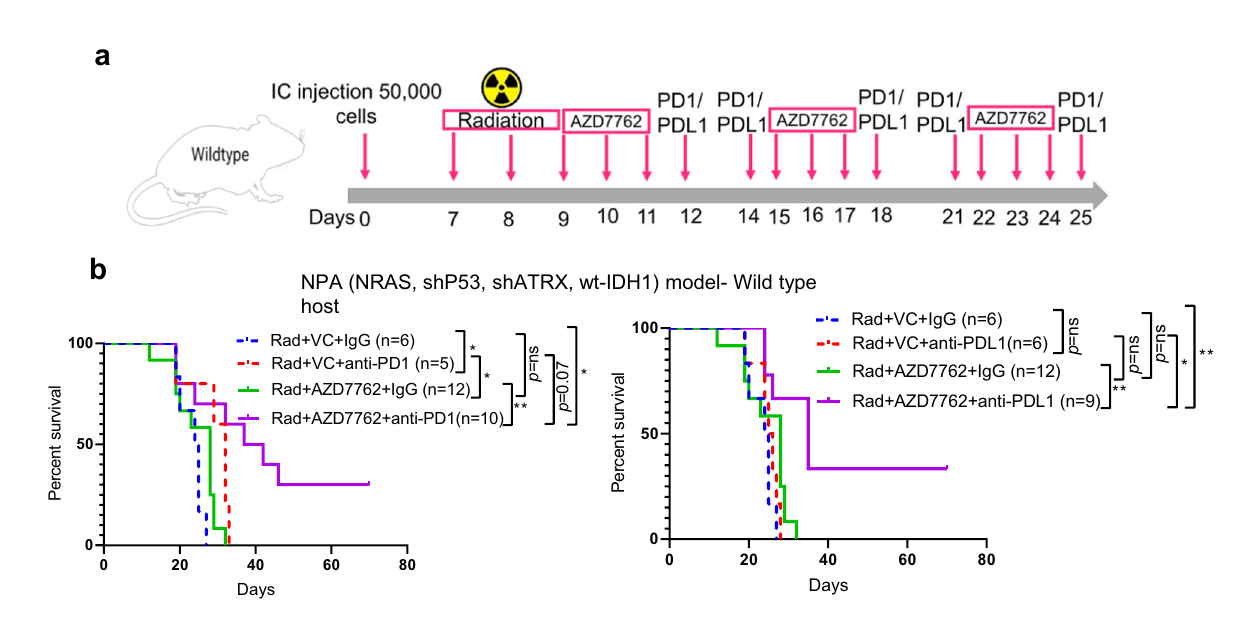
Fig. 8 | The combination of radiotherapy, AZD7762 and PD-1/PD-L1 blockade improves the survival of glioma-bearing mice in NPA glioma model. a The schematic representation of the dosing scheme followed for the survival experi- ment. b (Left) KM survival curves for NPA glioma-bearing C57BL/6 mice. Seven days after intracranial implantation, all the animals were irradiated with 3Gy whole-brain radiation for 3 consecutive days. 9 days after tumor implantation, the animals were randomized into 4 groups: vehicle control ( n =6), anti-PD-1 ( n =5), AZD7762(Chek1/2inhibitor)( n =12)andAZD7762+anti-PD-1( n =10)combination group.Survivalanalysiswasperformedusingthelog-ranktest.Themediansurvival duration in the treatment groups were as follows: Rad + VC+IgG, 24.5 days; Rad+ VC+anti-PD-1, 32 days; Rad + AZD7762+IgG, 28 days; Rad + AZD7762+anti-PD-1, 39.5days.Statistics:Rad+VC+IgGvsRad+VC+anti-PD-1, p =0.02;Rad+VC+IgG vsRad+AZD7762+IgG, p